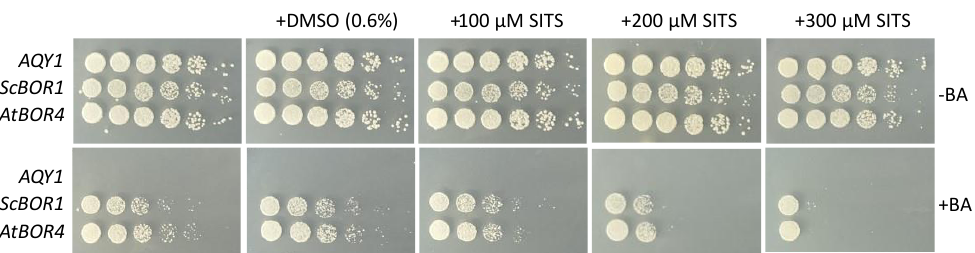
Figure 3. Borate transporters are sensitive to SITS. Plasmids encoding the specified gene were tested against increasing concentrations of SITS in 0.6% dimethyl sulfoxide (DMSO) in the presence or absence of 20 mM boric acid and plated on CSM-His selective media. Plates were incubated at 30 ◦ C and imaged after 5